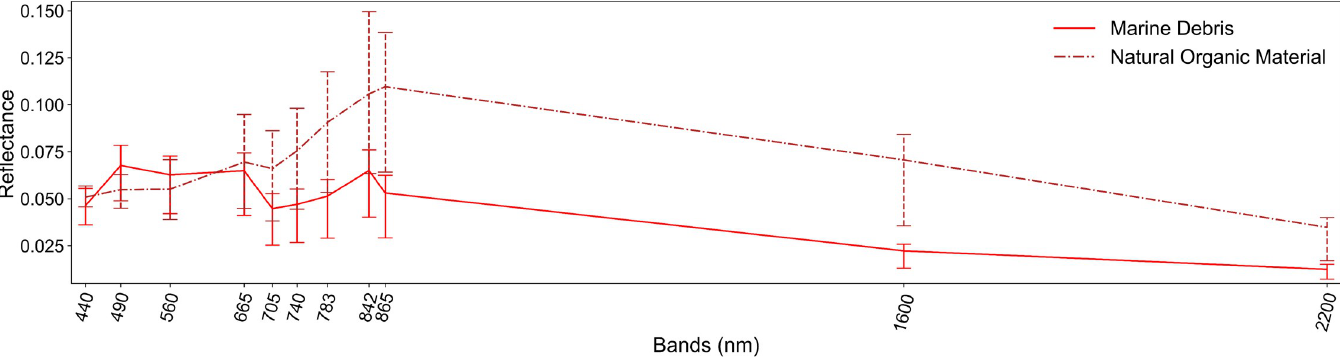
Fig 3. The spectral signatures of the Marine Debris and Natural Organic Material classes derived from the annotations with the high confidence levels. The mean spectral signatures are presented with 25–75 percentiles as error bars.